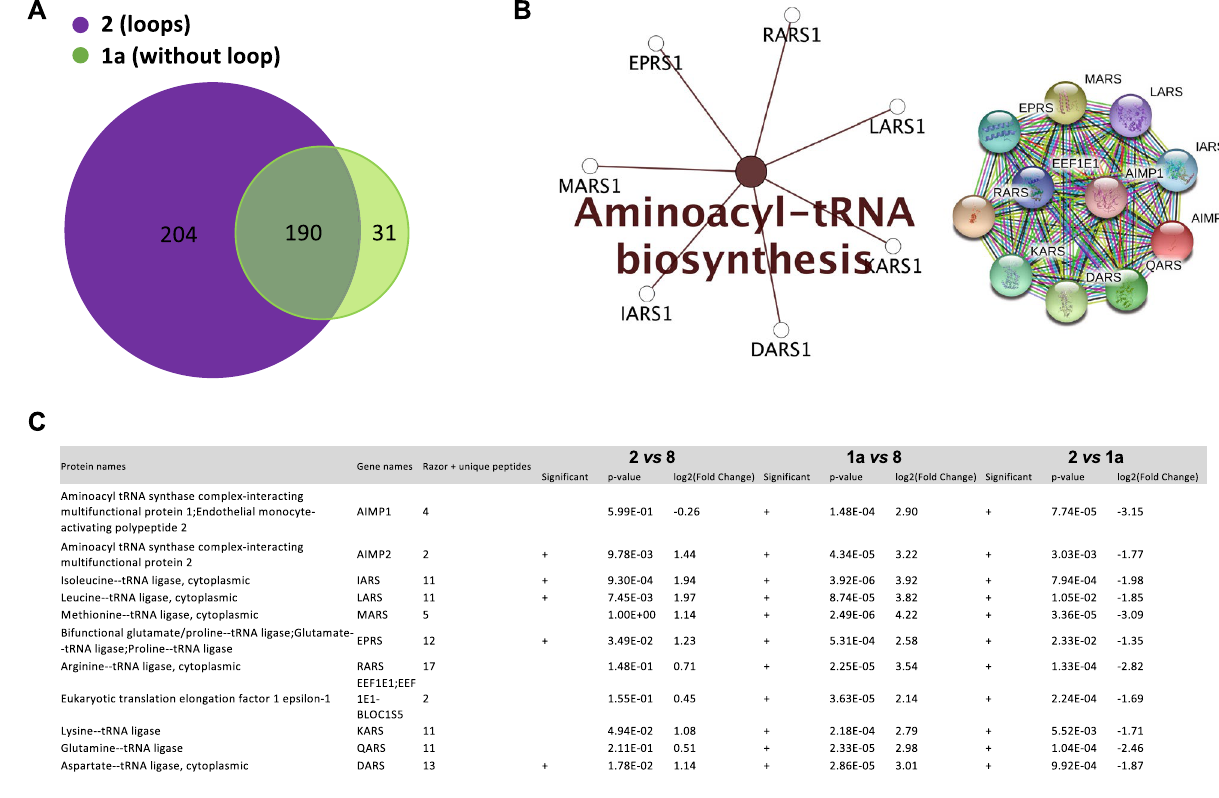
Figure 4. Differential interaction of human proteins with constrained G4 structures adopting different topologies. ( A ) Diagram showing the differential enrichment of human proteins on 1a (green) and 2 (purple) constructions. Differential enrichment of proteins on structures 1a or 2 was determined through statistical analysis using the fold change ≥ 2 and p -value < 0.05, allowing to reach a false discovery rate (FDR) inferior to 5%. ( B ) KEGG pathway covered by the 31 proteins found enriched on constrained G4 structure 1a and functional interaction network analysis using STRING 51 for the 31 proteins found enriched on construction 1a . A right-sided (Enrichment) test based on the hyper-geometric distribution was performed on the corresponding Entrez gene IDs for each gene list and the Bonferroni adjustment ( p < 0.05). ( C ) MS-based quantitative p -value < 0.05, allowing to reach a false discovery rate (FDR) inferior to 5% according to the Benjamini– Hochberg